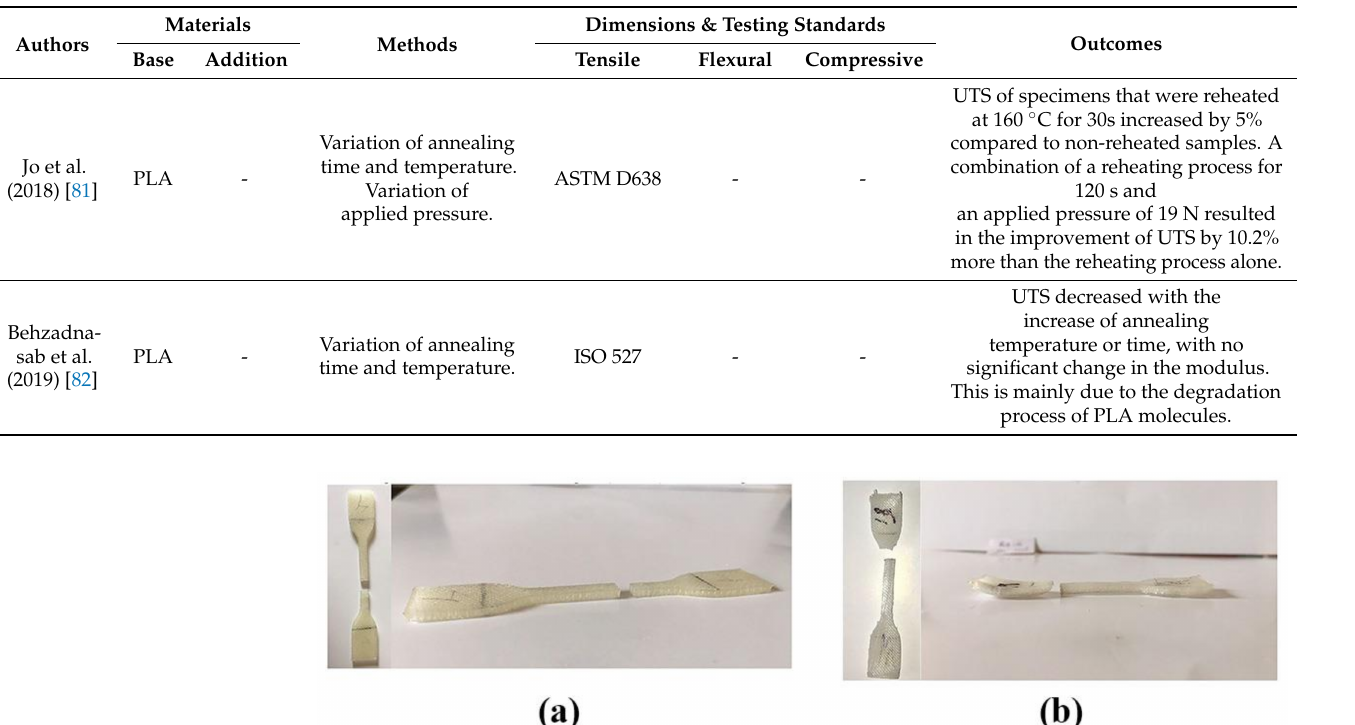
Table 6. Research on annealing post-processing.